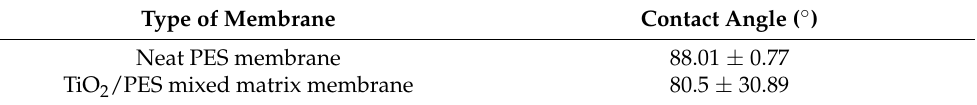
Table 1. Contact angle measurement for neat a PES membrane and the TiO 2 /PES mixed matrix membrane.